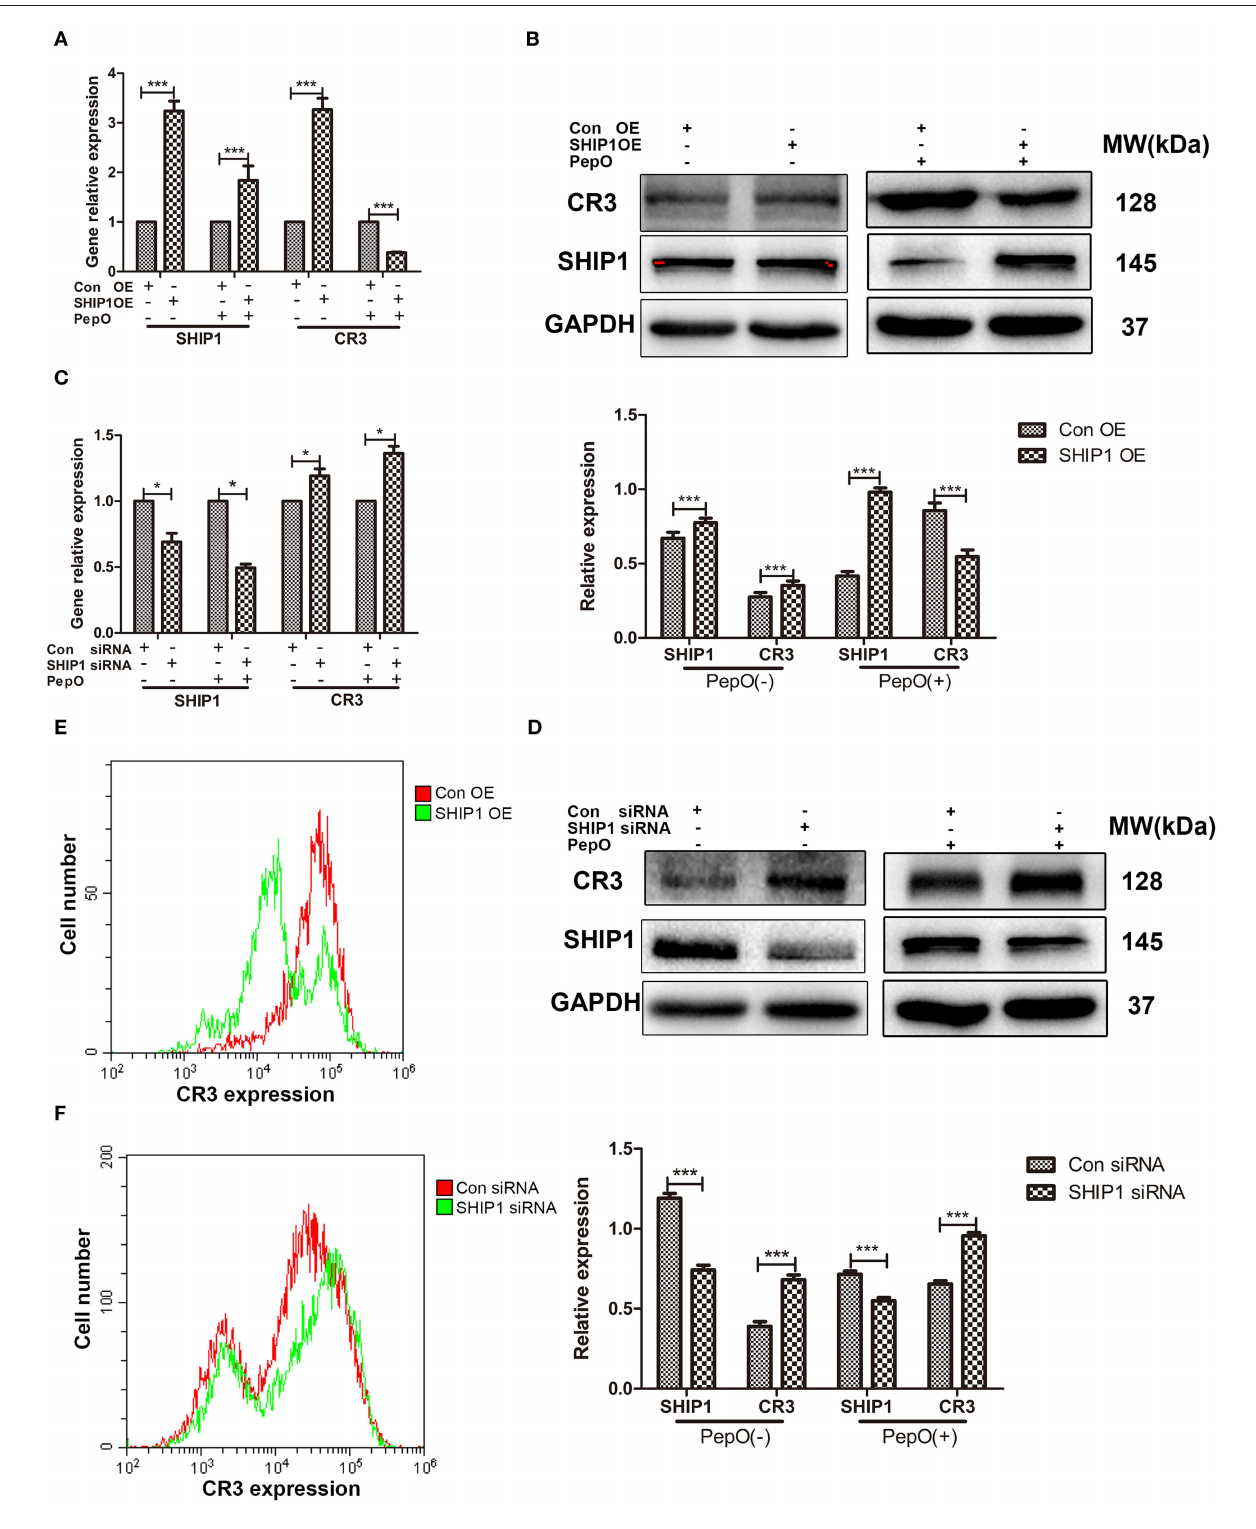
FIGURE 3 | Regulation of CR3 expression by SHIP1 in PepO-stimulated PEMs. (A–F) PEMs were transfected with pHBLV-CMV-SHIP1 plasmid, pHBLV-CMV-MCS control plasmid (A,B,E) , SHIP1 siRNA, or scrambled siRNA (C,D,F) for 24h followed by PepO or medium stimulation for another 24h. SHIP1 and CR3 transcripts were determined by Q-PCR analysis, and SHIP1 protein was determined by WB analysis. CR3 protein was determined by WB and flow cytometry analysis. Representative bands from three independent repeated experiments are shown. Data are shown as mean ( ± SD) of three independent repeated experiments. Statistical analysis was performed by two-way ANOVA test. *** p < 0.001, * p < 0.05, Con, control; OE, over-expression.